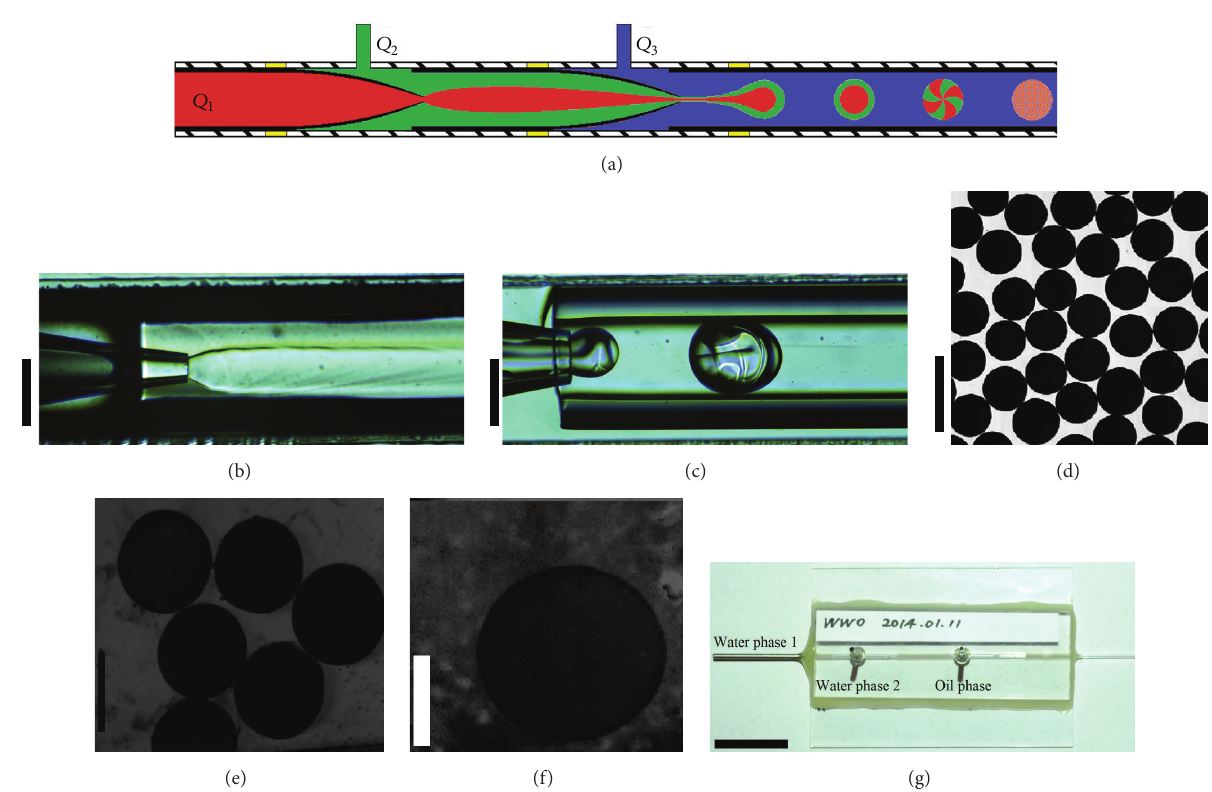
Figure 2: (a) Schematic configuration of the microfluidic system for synthetizing the MTNs. 𝑄 1 (20 𝜇 Lmin −1 ), 𝑄 2 (20 𝜇 Lmin −1 ), and 𝑄 3 (120 𝜇 L min −1 ) are the flow rates for the inner, middle, and outer phases, respectively. (b) The two aqueous phases meet and form a continuous laminar flow at the outlet of the first capillary. (c) The generation of ((𝑊 + 𝑊)/𝑂) emulsions at the outlet of the second capillary. (d), (e), and (f) Magnified picture of different sizes (200, 100, and 20 𝜇 m) of magneto-thermoresponsive nanocomposites (MTNs) fabricated with the capillary microfluidic device. (g) A typical microfluidic device fabricated for preparing the MTNs. Scale bars are 400 𝜇 m in (b), (c), and